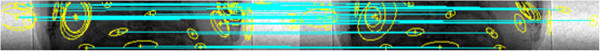
Three in-line phase-contrast experimental projection images of the mouse’s chest taken from several different angles.